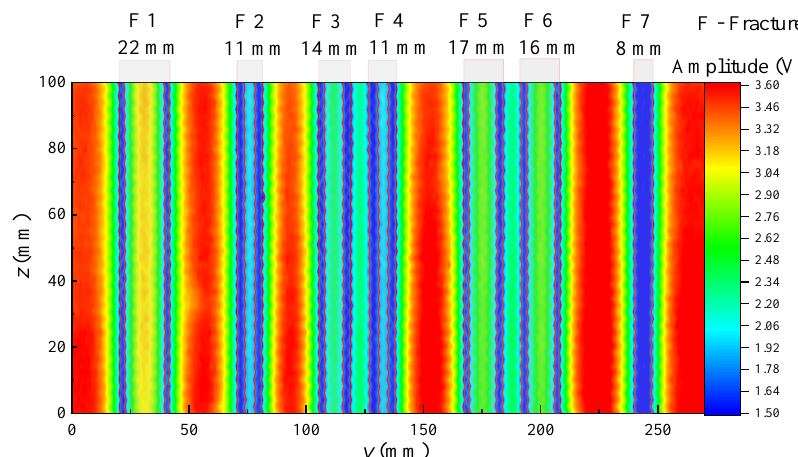
Figure 17. Echo amplitude imaging diagram for the grooved sandstone Plate 1.